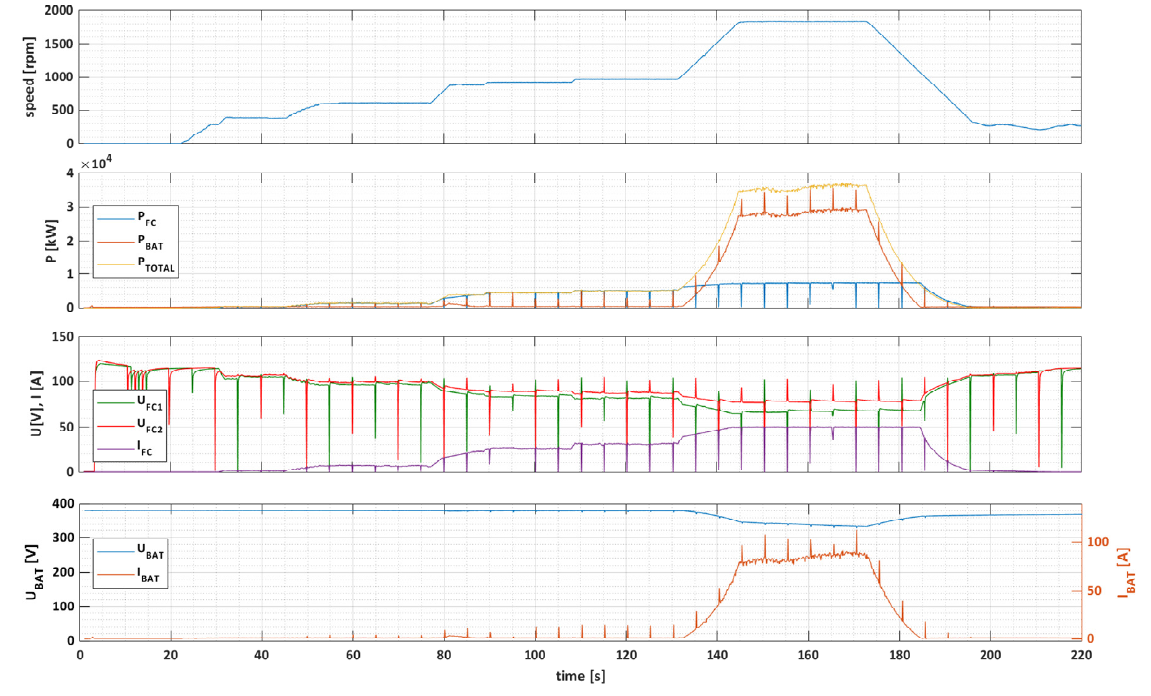
Figure 13. Selected results from the motor glider tests on the runway.